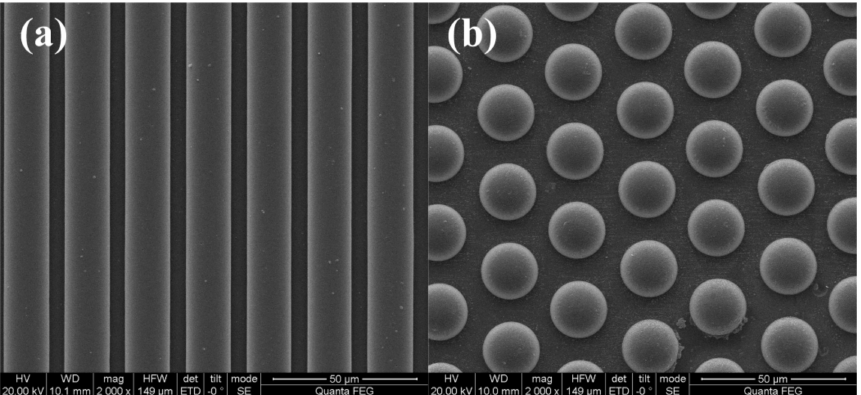
Figure 9. SEM images of the patterned composite films with different microstructures of ( a ) strip waveguides and ( b ) microlens